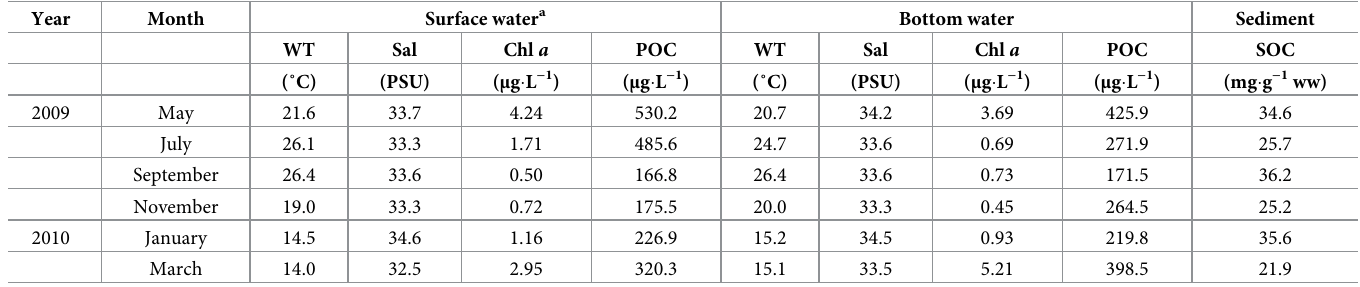
Table 1. Environmental characteristics at the sampling